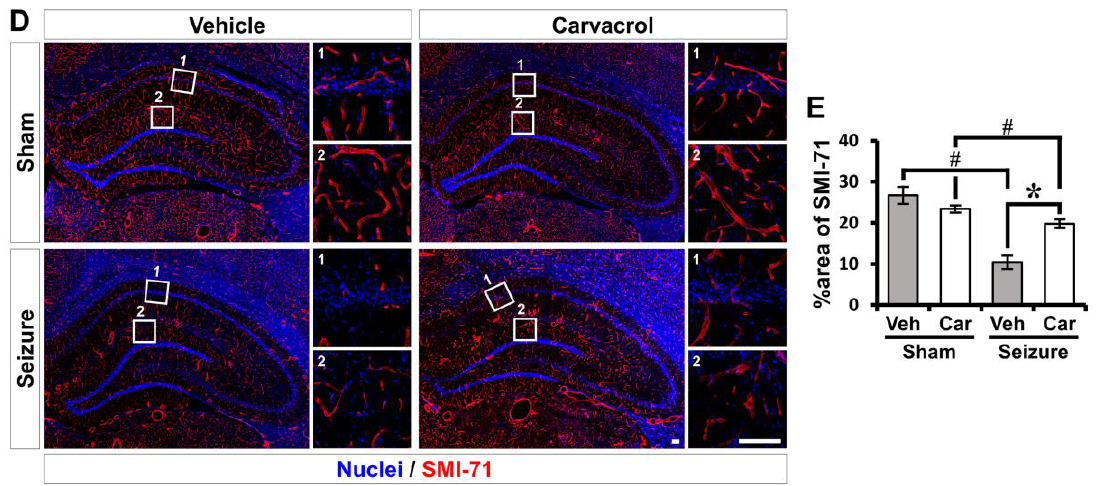
Figure 5. Carvacrol treatment reduces the blood – brain barrier (BBB) disruption and vessel disappearance following pilocarpine-induced SE. ( A ) Photomicrographs showing sections of the hippocampus stained for anti-mouse immunoglobulin G (IgG) to detect endogenous IgG. Scale bar, 100 µm. ( B ) Graph representing IgG leakage from the hippocampus in mice treated with the vehicle or carvacrol at 3 days following pilocarpine-induced SE (mean ± SEM; n = 5 from each sham group, n = 7 from each seizure group). * p < 0.05 vs. the vehicle-treated group; # p < 0.05 vs. the sham-operated group (Kruskal – Wallis test followed by Bonferroni post-hoc test; chi square = 18.493, df = 3, p < 0.001). ( C ) Double Immunofluorescent images representing the BBB marker SMI-71 + endothelial protein (gray) and endogenous IgG leakage (red) in the hippocampus. Nuclei are counterstained with DAPI (blue). Scale bar = 20 µm. ( D ) Representative images showing the SMI-71 + endothelial protein (red) in the hippocampus. Nuclei are counterstained with DAPI (blue). Scale bar, 100 µm. ( E ) Quantification of the percent area of the SMI-71 + endothelial protein in the hippocampus (mean ± SEM; n = 3 – 4 from each sham group, n = 5 – 7 from each seizure group). * p < 0.05 vs. the vehicle-treated group; # p < 0.05 vs. the sham-operated group (Kruskal – Wallis test followed by a Bonferroni post-hoc test: chi square = 19.080, df = 3, p < 0.001).